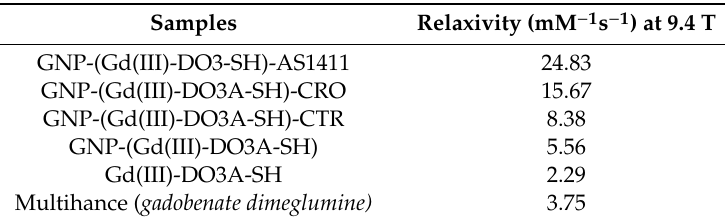
Table 5. Relaxivity values for gold nanoparticles functionalized with Gd(III)-DO3A-SH and oligonucleotides AS1411 /